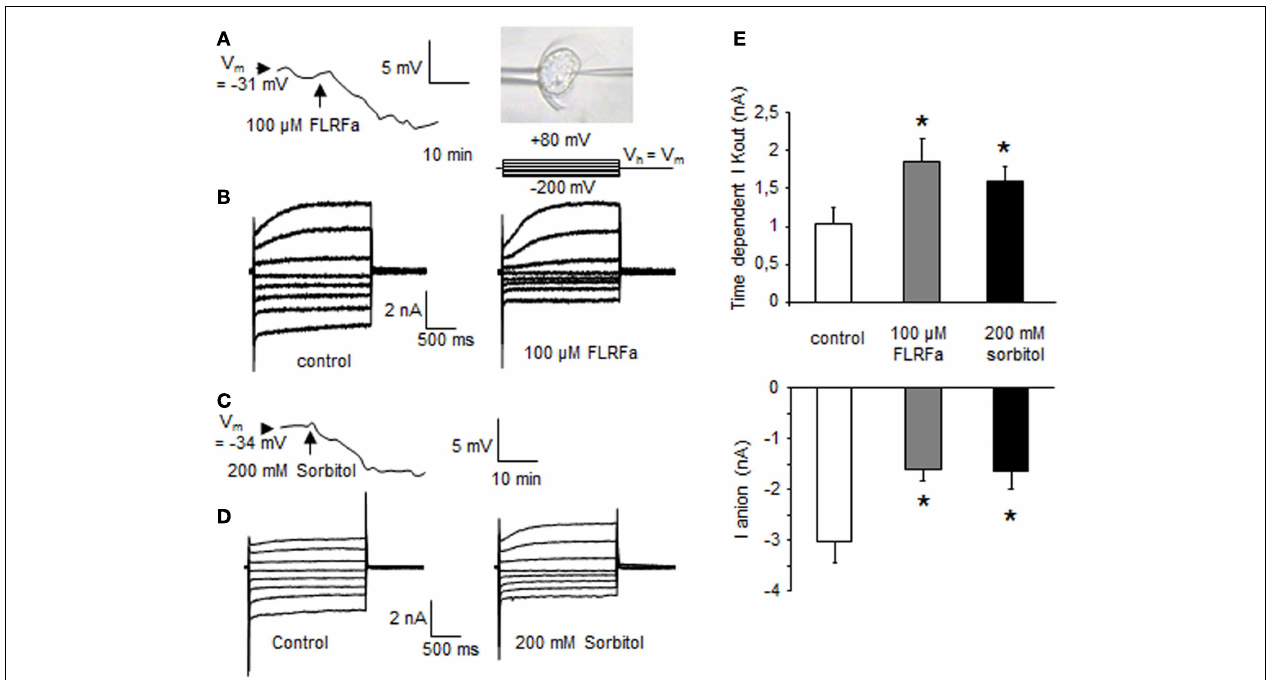
was as illustrated, holding potential (V h ) wasV m . Mean values of anion currents recorded at − 200mV after 1.8s and of time dependent K + outward currents at + 80mV after 1.8 s (E) .The data correspond to means of four independent experiments and error bars correspond to SD. *Significantly different from controls, P <